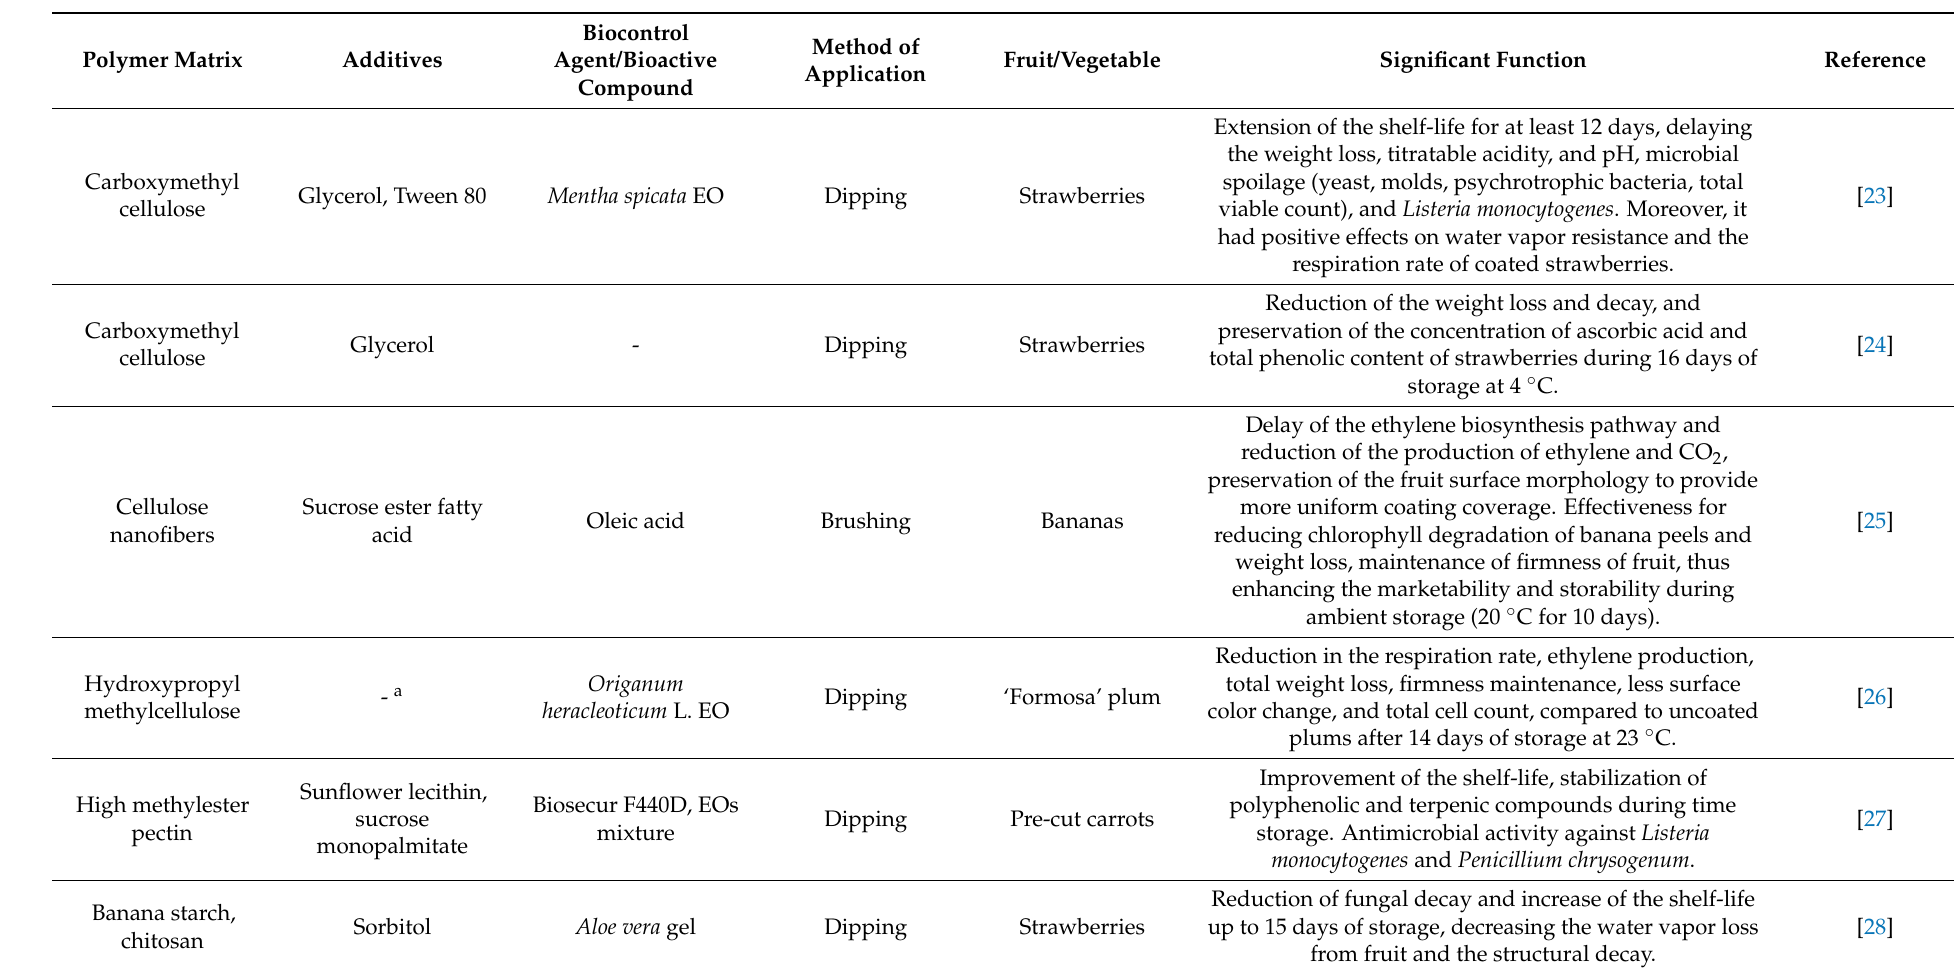
Table 1. Polysaccharide-based coatings for different fresh